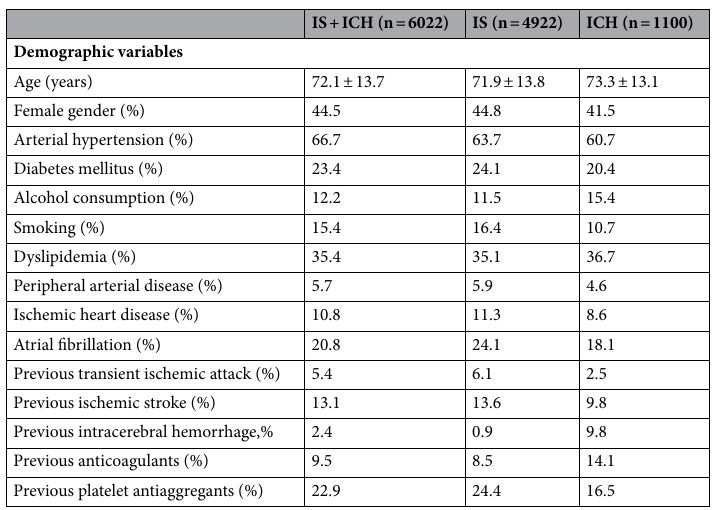
Table 1. Demographic variables of the experimented dataset of patients summarized by